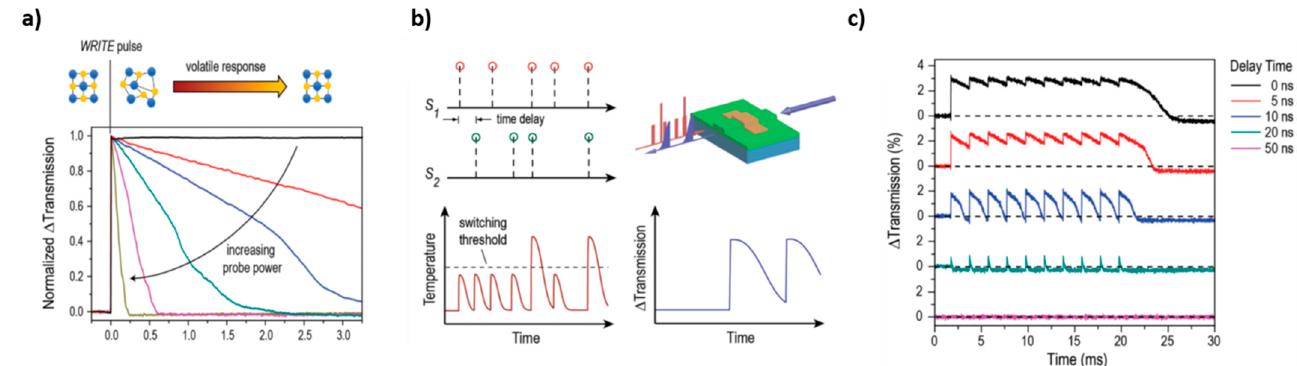
Figure 17. ( a ) Variation of the optical transmission with increasing optical probe power. At low probe powers (black line), the device remains in the amorphous state for nonvolatile operation, while increasing the probe power causes recrystallization of the GST225; ( b ) detection of coincident events between two signals using volatile phase-change memory. Only when two pulses overlap in time, the combined optical power surpass the threshold required to reach an amorphous state (higher transmission level) and can be detected by the device; ( c ) multipulse device dynamics using two pulse trains with varying time delays between them. When the two pulse trains are overlapped in time, the transmission is at a maximum, indicating the two signals are correlated. Reproduced from Ref. [116] with permission from Wiley.